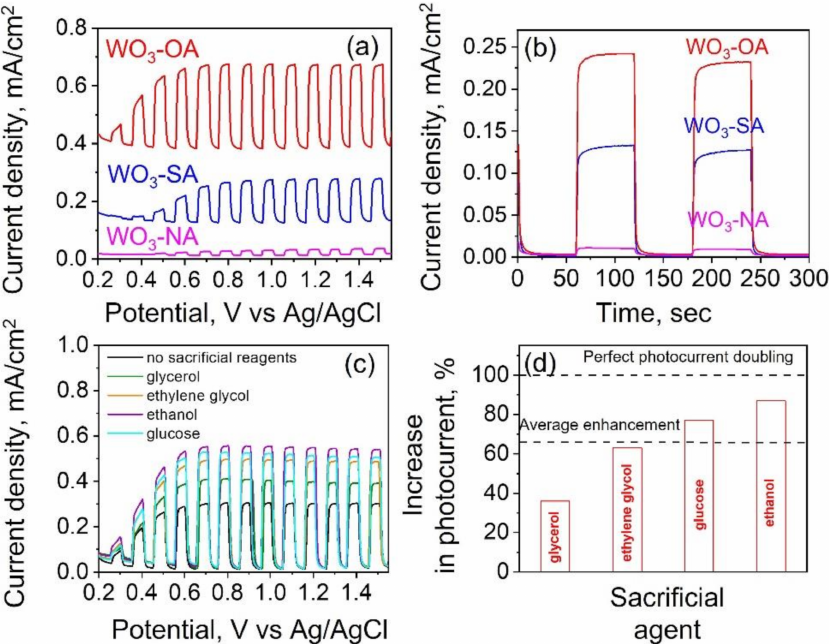
Figure 5. LSV curves ( a ) and transient photocurrent response at 0.8 V vs. Ag/AgCl ( b ) under chopped solar illumination in 0.5 M H 2 SO 4 ; LSV curves ( c ) and increase in photocurrent ( d ) for WO 3 -OA sample in 5 mM sacrificial agent solution compared with 0.5 M H 2 SO 4